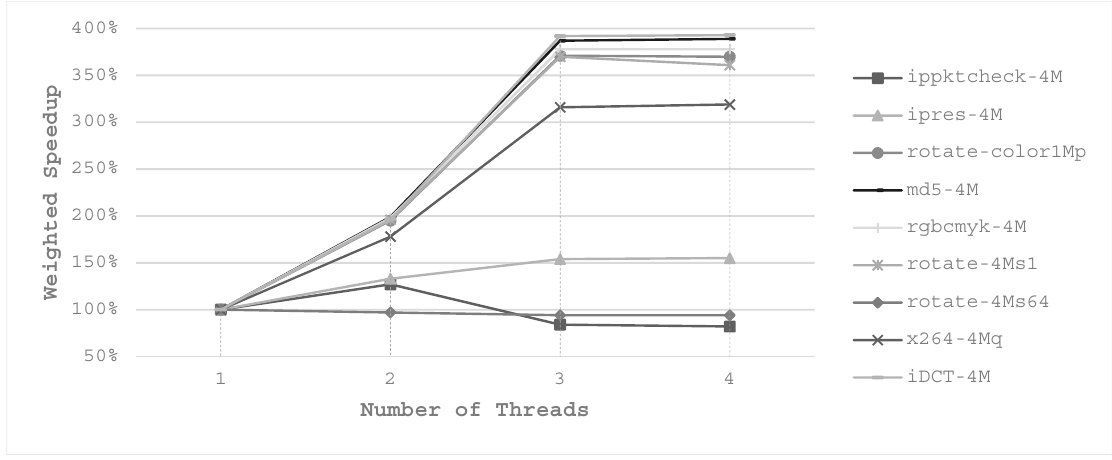
Figure 3. Weighted speedup of parallel workloads with multi-thread with respect to single-thread. But when multiple threads are running in parallel, there will be more cache size to be allocated.